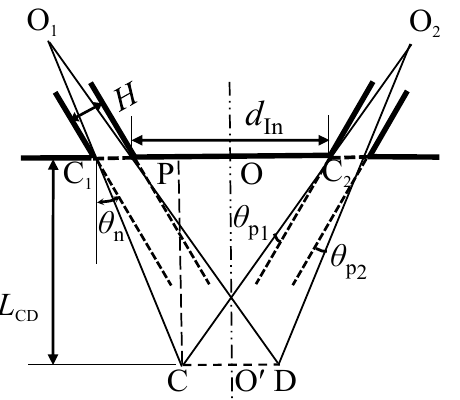
Figure 3. Local geometric demonstration for the focal plane of the powder stream.